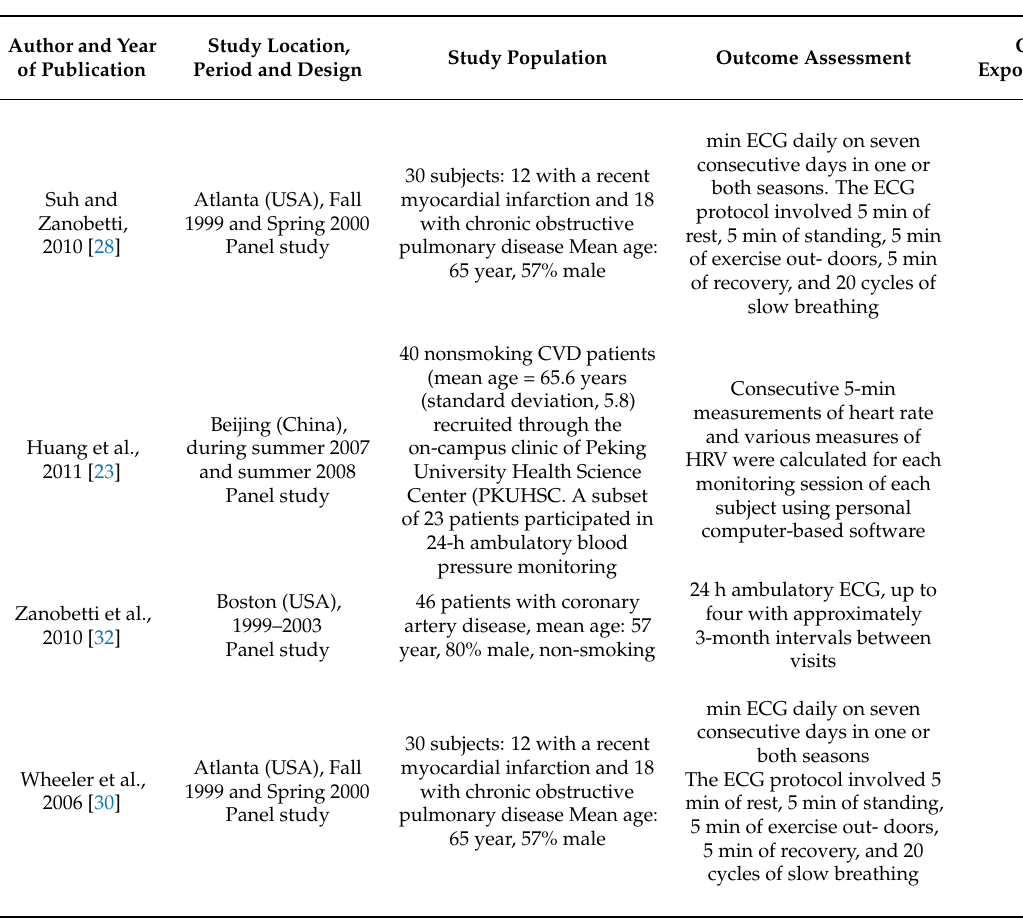
Table 2. Basic characteristics of the studies included in the